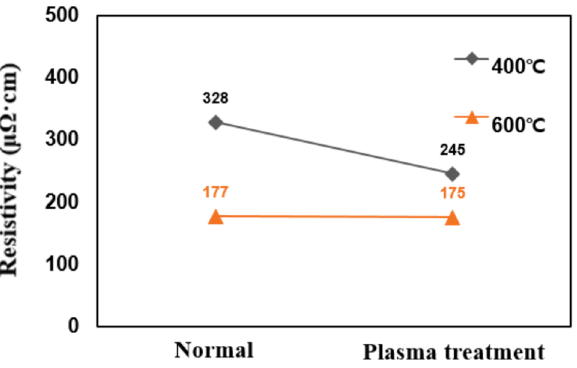
Figure 9. Resistivity changes due to post-plasma treatment after